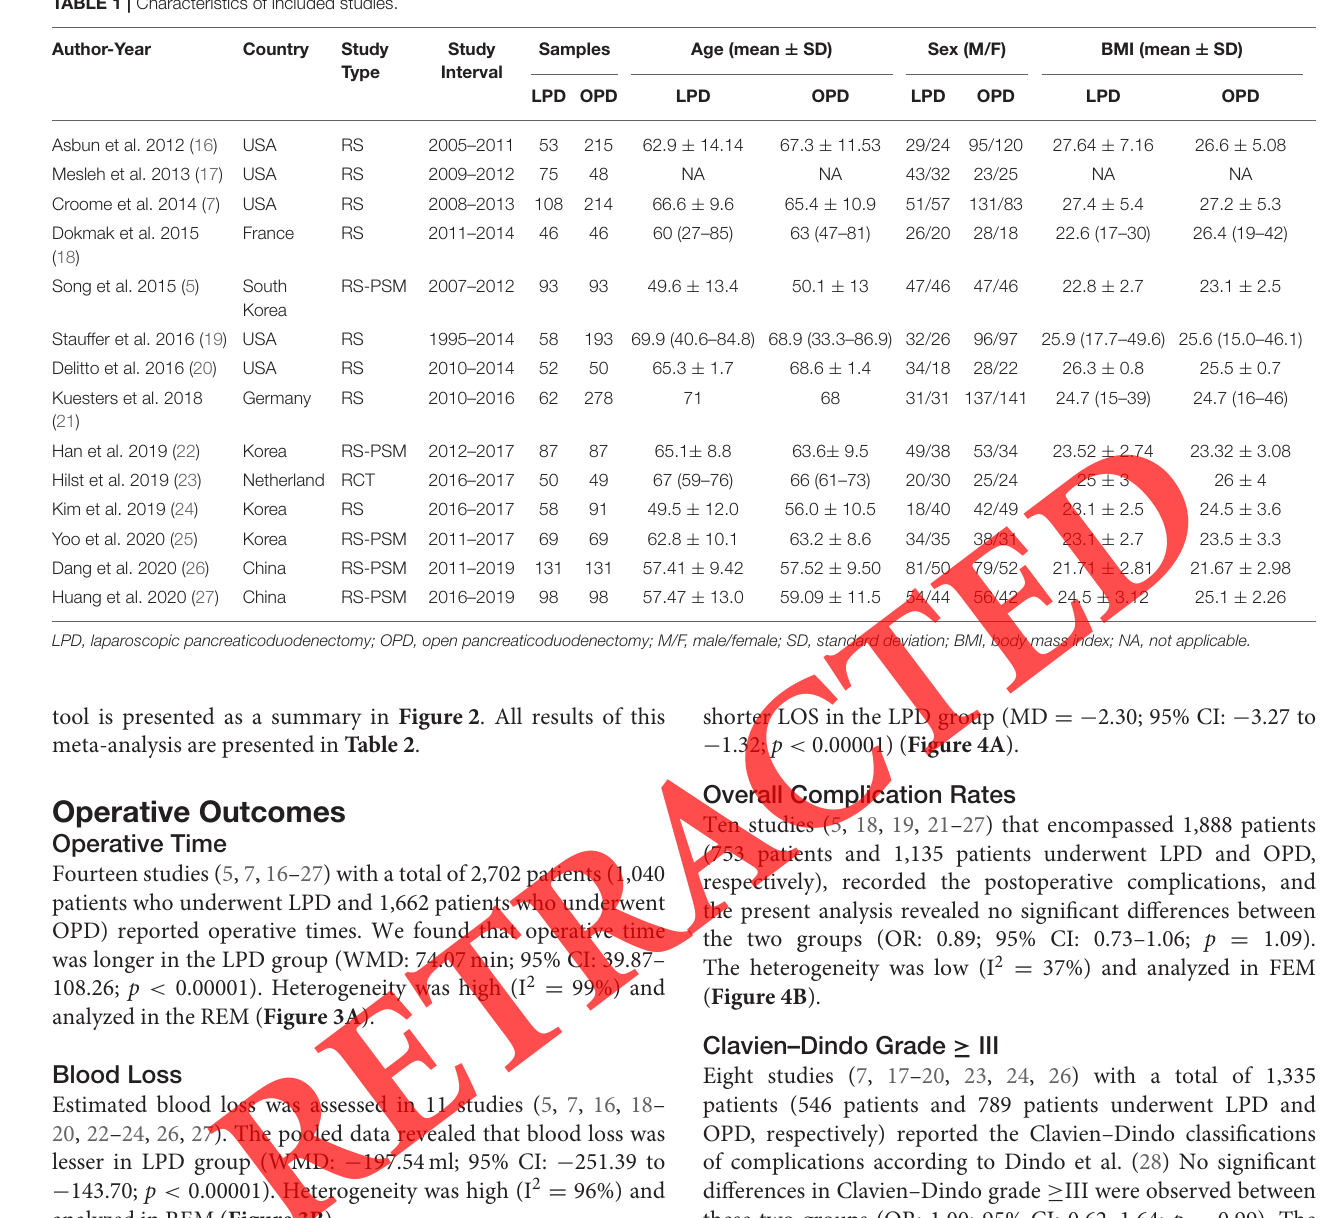
TABLE 1 | Characteristics of included